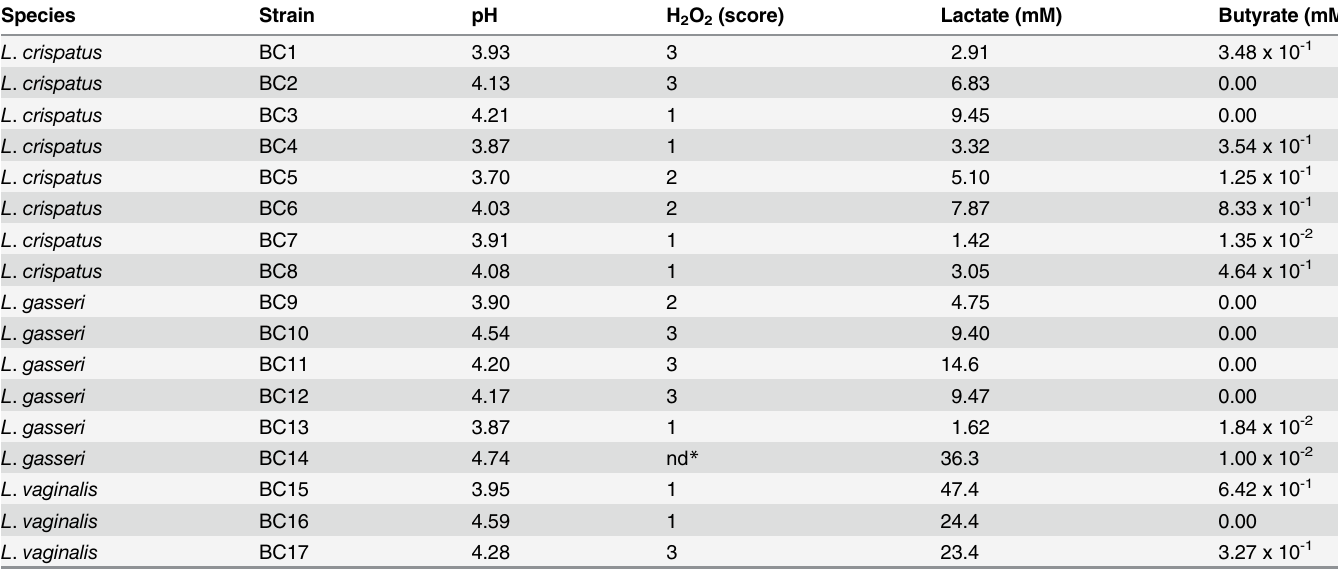
Table 1. Characterization of the vaginal lactobacilli: taxonomy, pH of cultural supernatants and production of antimicrobial compounds.